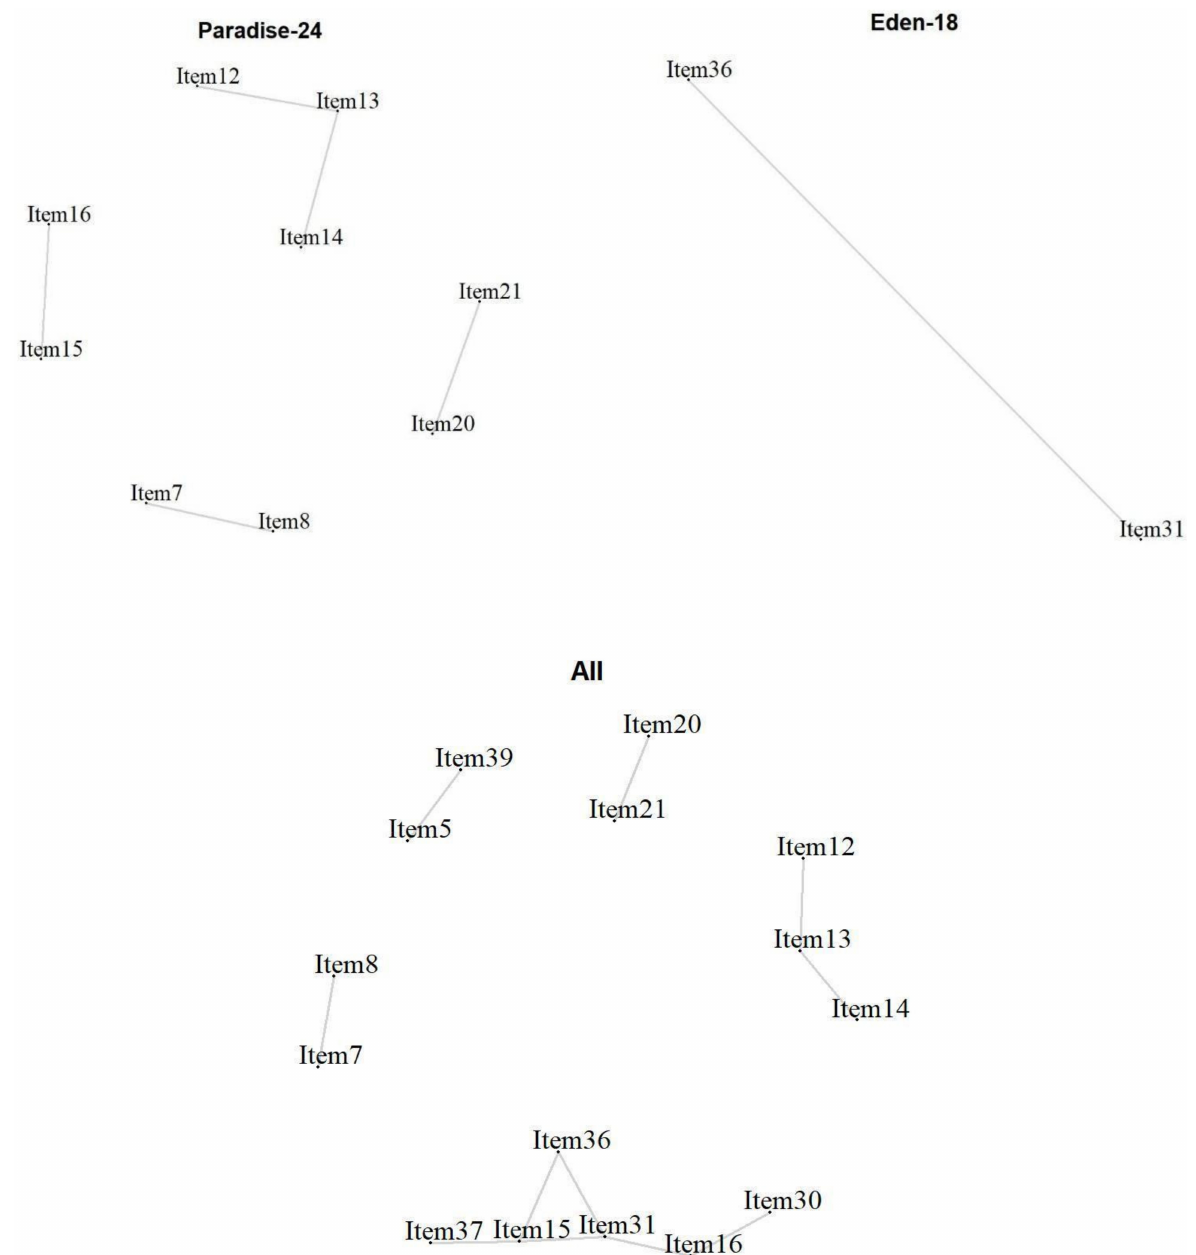
Figure 4. Local item dependencies above cut-off for the 24 Paradise items, the 18 additional Eden items, and the two